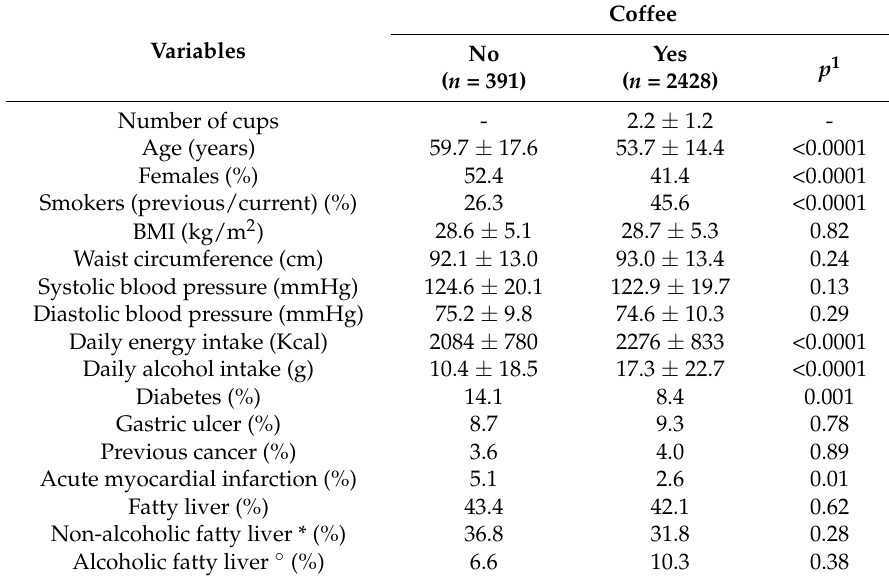
Table 1. Demographic and other characteristics of the study subjects by coffee